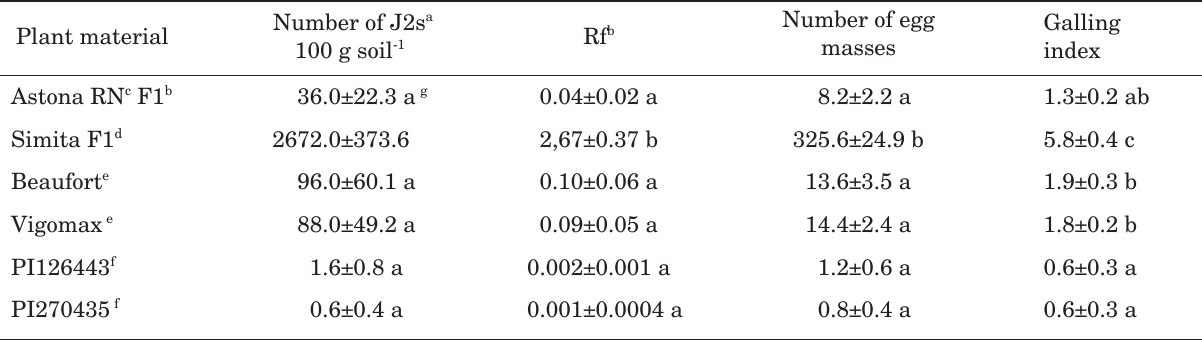
Table 3. Response of Meloidogyne incognita race 2 at 24°C soil temperature to tomato rootstocks, resistant and susceptible cultivars, and heat-stable plants.